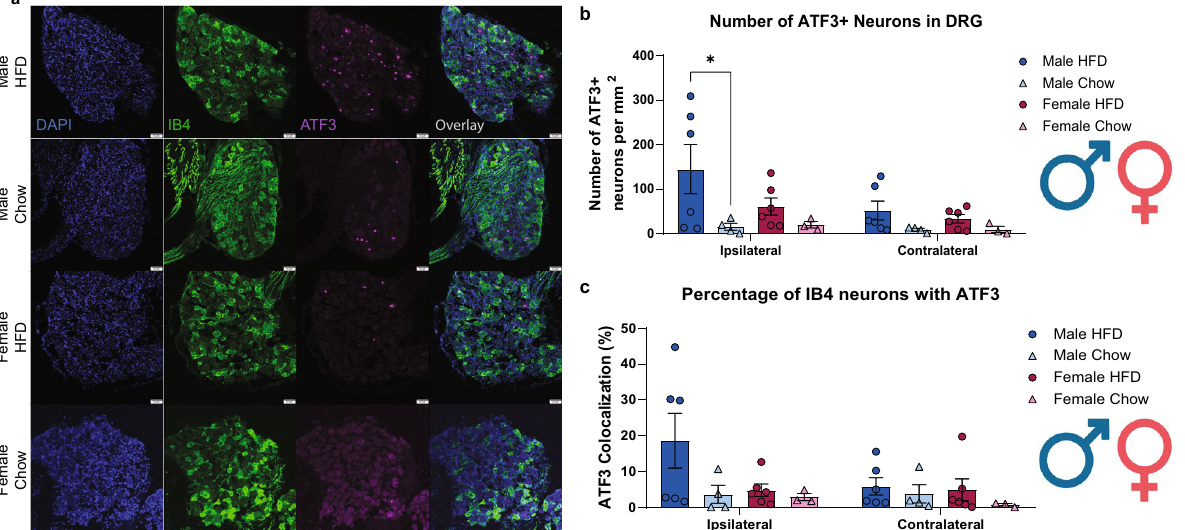
Figure 4. A short-term HFD regime induces ATF3 upregulation in lumbar DRGs. ( a ) Ipsilateral lumbar (L3-L5) DRGs from both diet groups were immunostained with DAPI (blue), IB4+ (green), and ATF-3 (purple). ( b ) There was a diet-dependent increase in ATF3 expression in HFD males (n = 6) and females (n = 6) compared to their chow male (n = 4) and female (n = 3) counterparts in both ipsilateral and contralateral lumbar DRG; however, only the HFD males had a significant ATF3 upregulation compared to their chow males in the ipsilateral DRG. There was no significant difference in ATF3 expression between ipsilateral and contralateral DRG. *p < 0.05 (Three-way ANOVA with Sidak’s post hoc multiple comparison). ( c ) There was an observed increase in ATF3 expression in IB4+ nociceptors in HFD males and females compared to their chow counterparts, but it did not reach the threshold of significance. Scale bar: 50